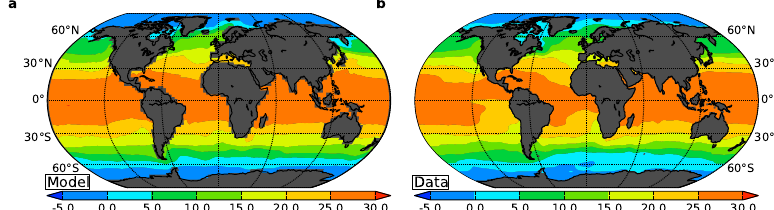
Figure 4. Temperature distribution ( ◦ C) at the ocean surface. Data from the World Ocean Atlas 2009 (Locarnini et al., 2010).